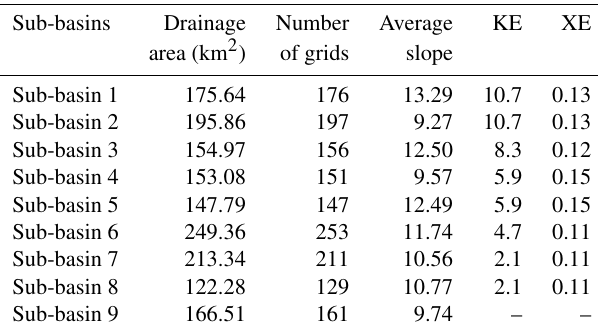
Figure 5. Sub-basins of the Qin River basin. (Note that the satellite images for the study area are available at http://www.gscloud.cn, last access: 18 November 2020.) Table 1. Detailed information of each